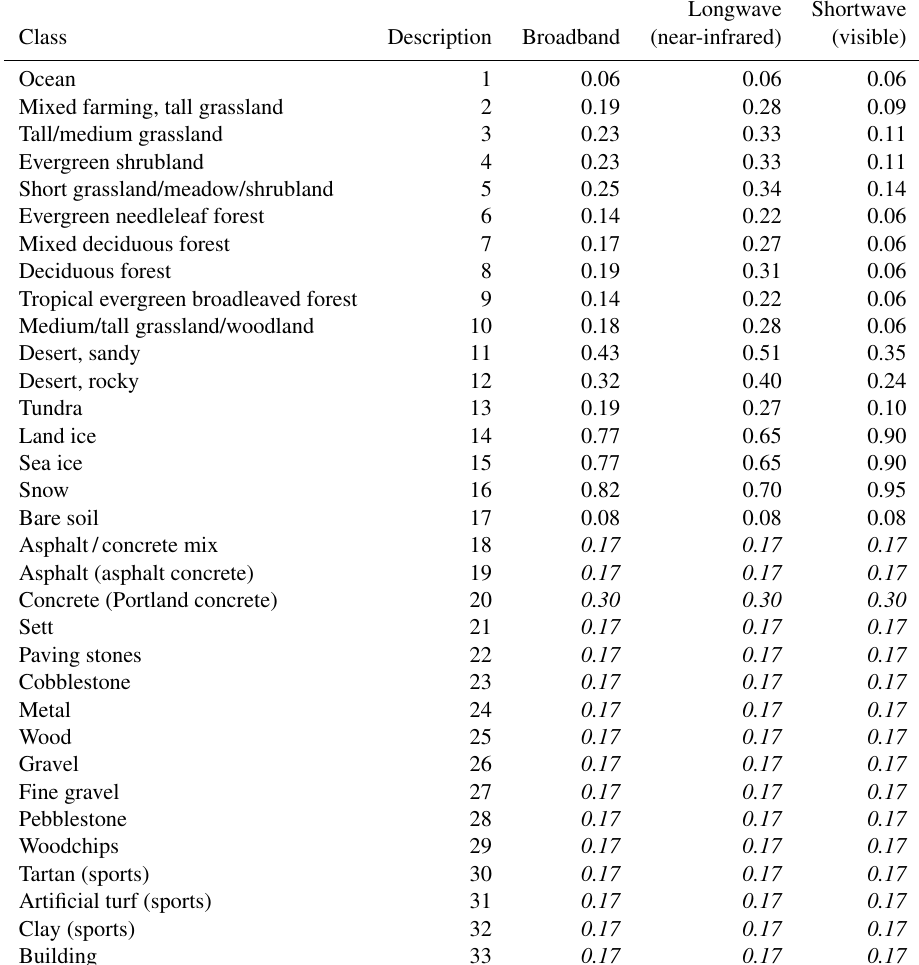
Longwave Shortwave